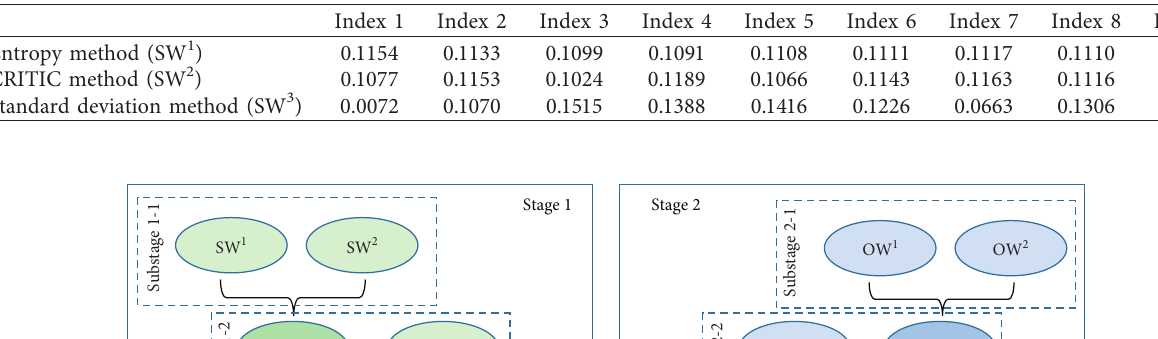
Table 11: Objective weight.